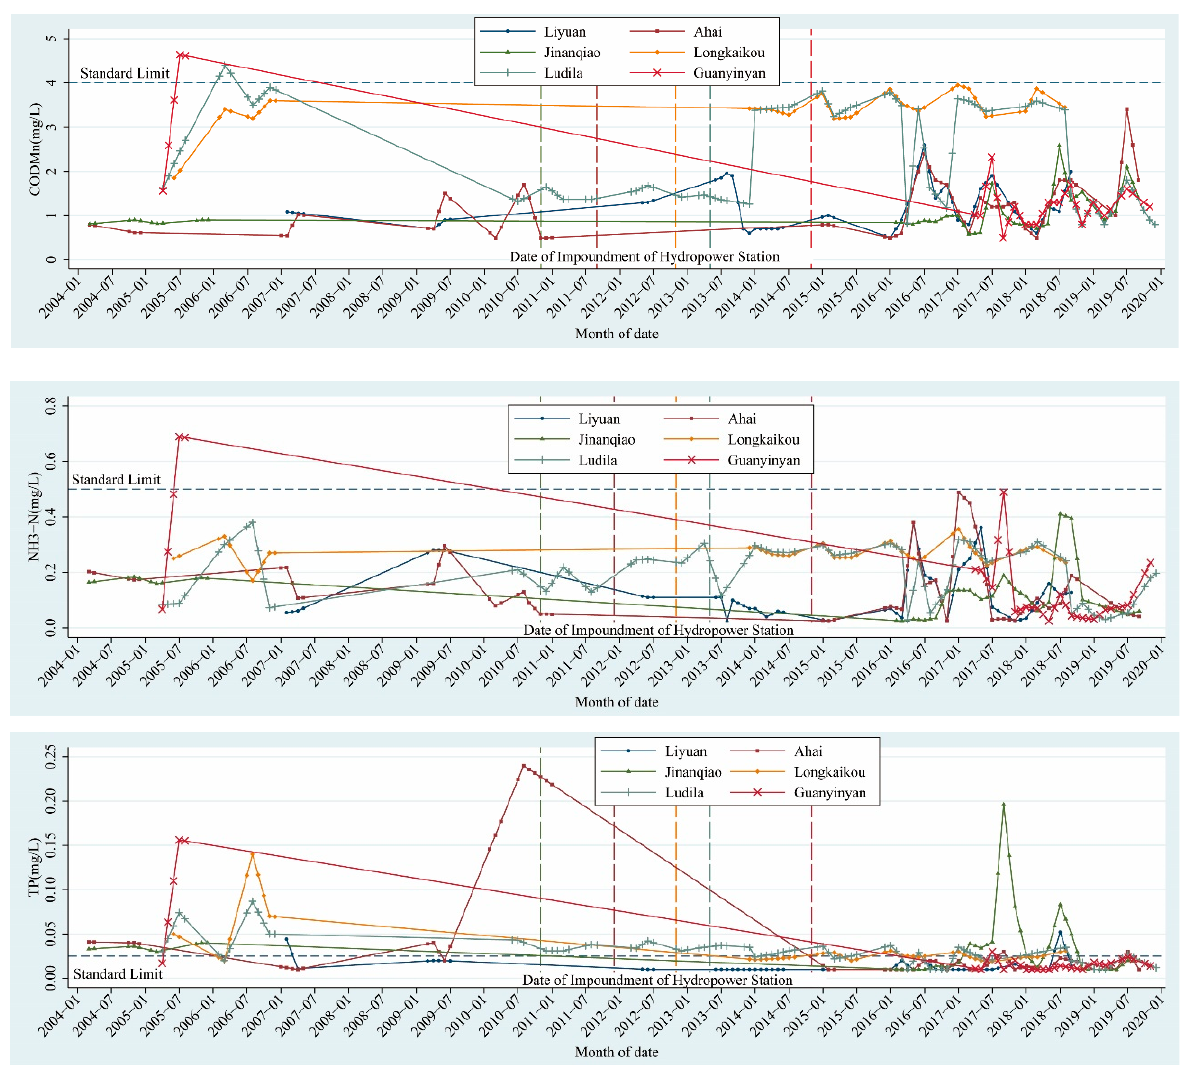
Figure 2. Water quality monitoring results at six hydropower stations on the middle reach of the Jinsha River.